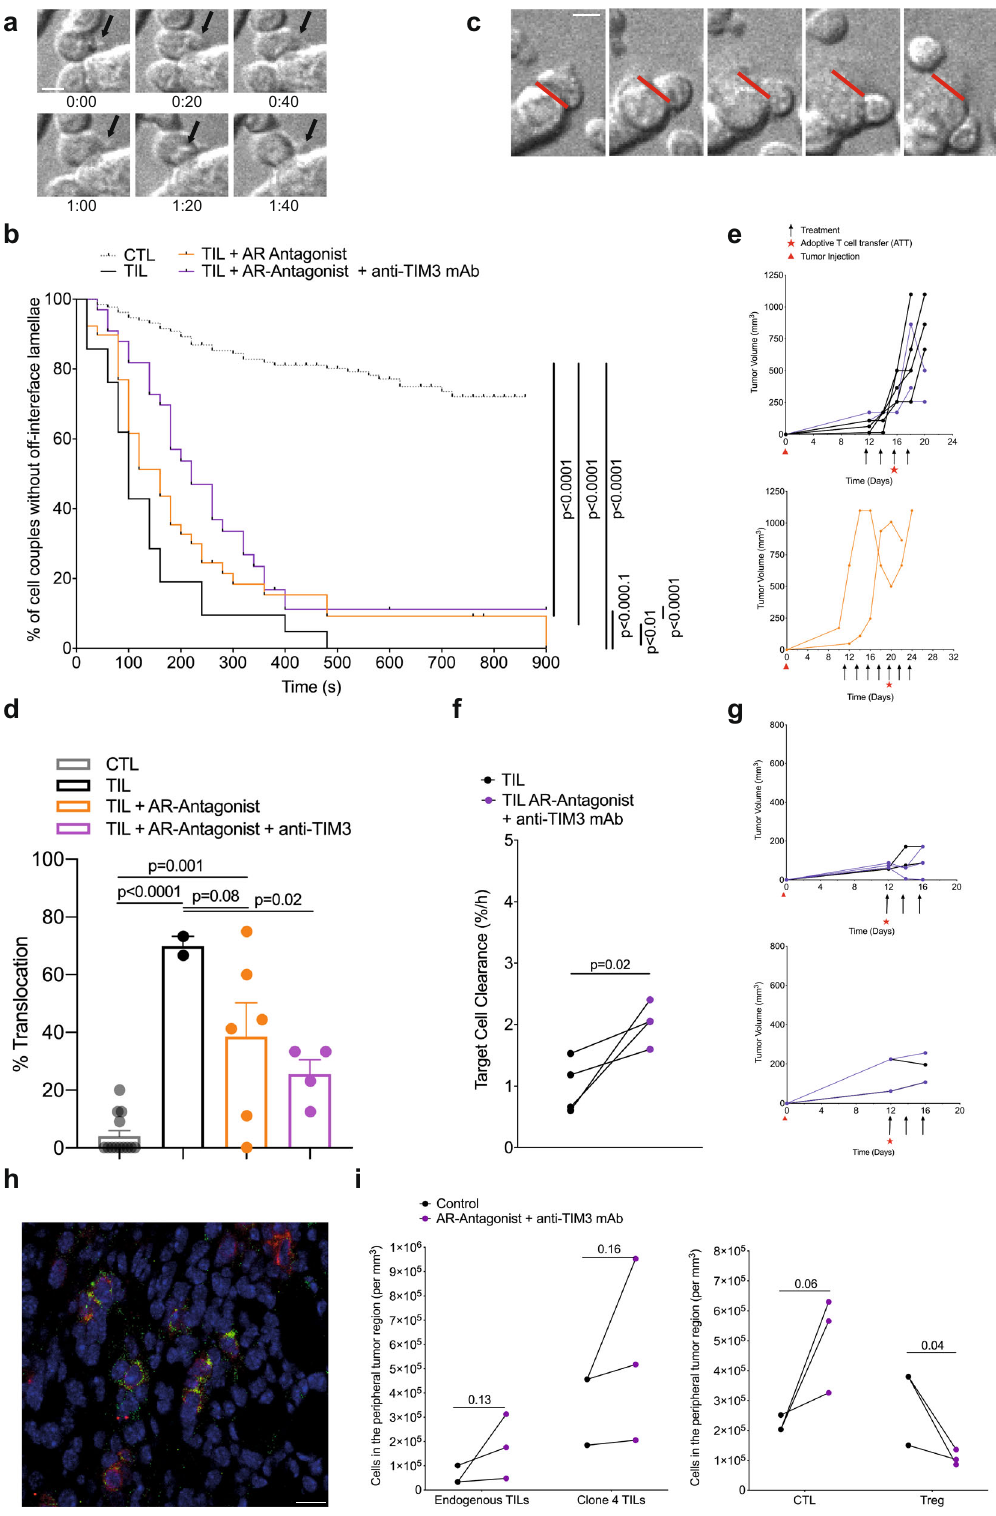
not diminish spheroid in fi ltration by CL4 CTL (Fig. 6a). How- ever, it diminished the ability of CL4 CTL to kill Renca target cells inside the spheroids as determined with DRAQ7 staining (Fig. 6b). Con fi rming TIM3-dependence, diminished Renca tumor cell killing could be reversed with the anti-TIM3 blocking mAb RMT3-23 (Fig. 6b). To determine the roles of A 2A R in tumor cell killing by CTL, we treated CL4 CTL/Renca